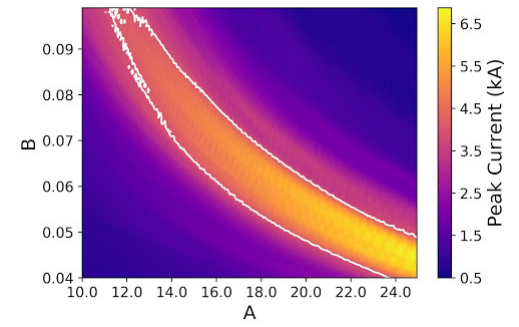
Figure 8. Peak current of the microbunches as a function of normalized modulation amplitude and chicane compression. The white contour line denotes 4 kA